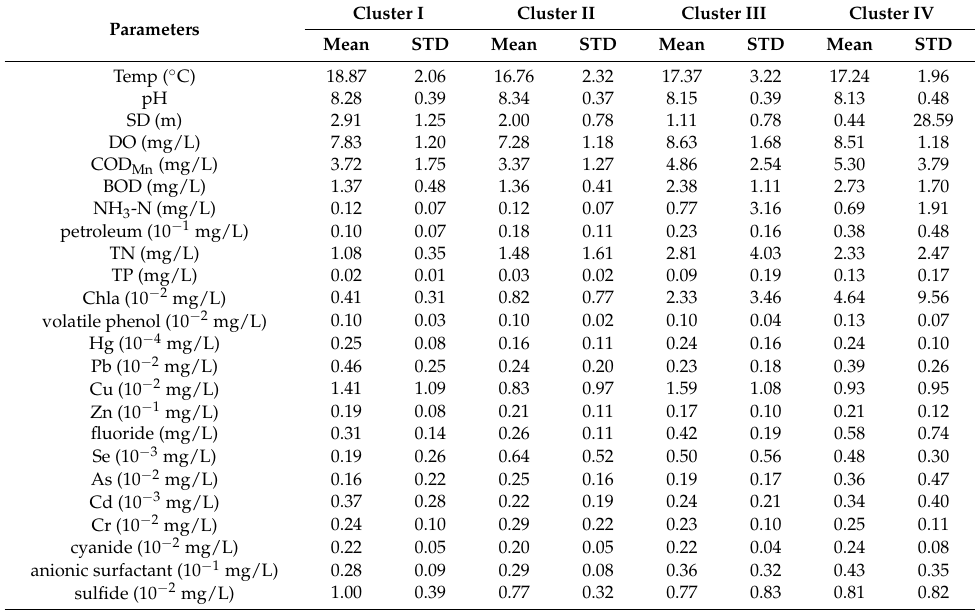
Table 2. Summary statistics of 24 parameters for the four